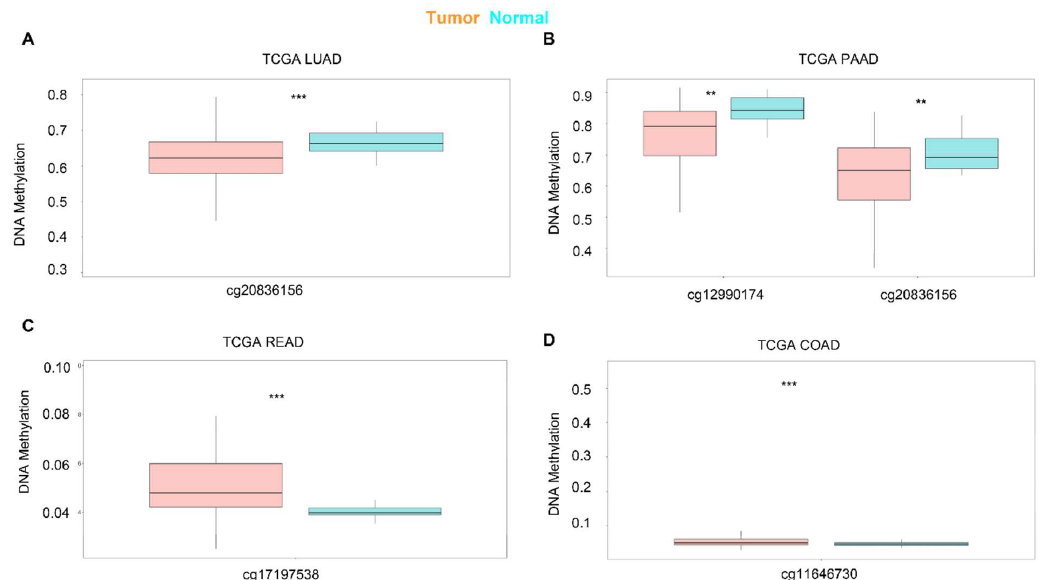
Figure 4. Expression level of the DNA methylation of KRAS in cancers. DNA methylation of KRAS has a low level of expression in LUAD ( A ) and PAAD ( B ), and a high level of expression in READ ( C ), and COAD ( D ) compared to normal samples. p -value ** < 0.01, p -value *** < 0.001.